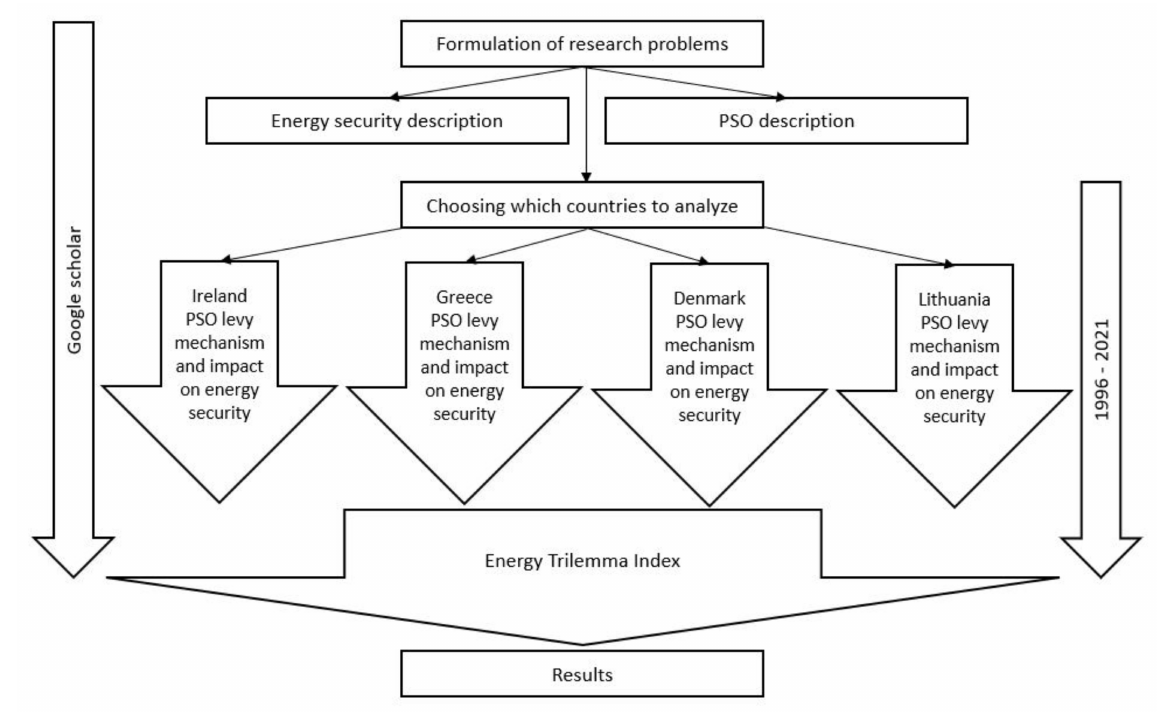
Figure 3. The flow of literature analysis followed in this work (designed by the authors).